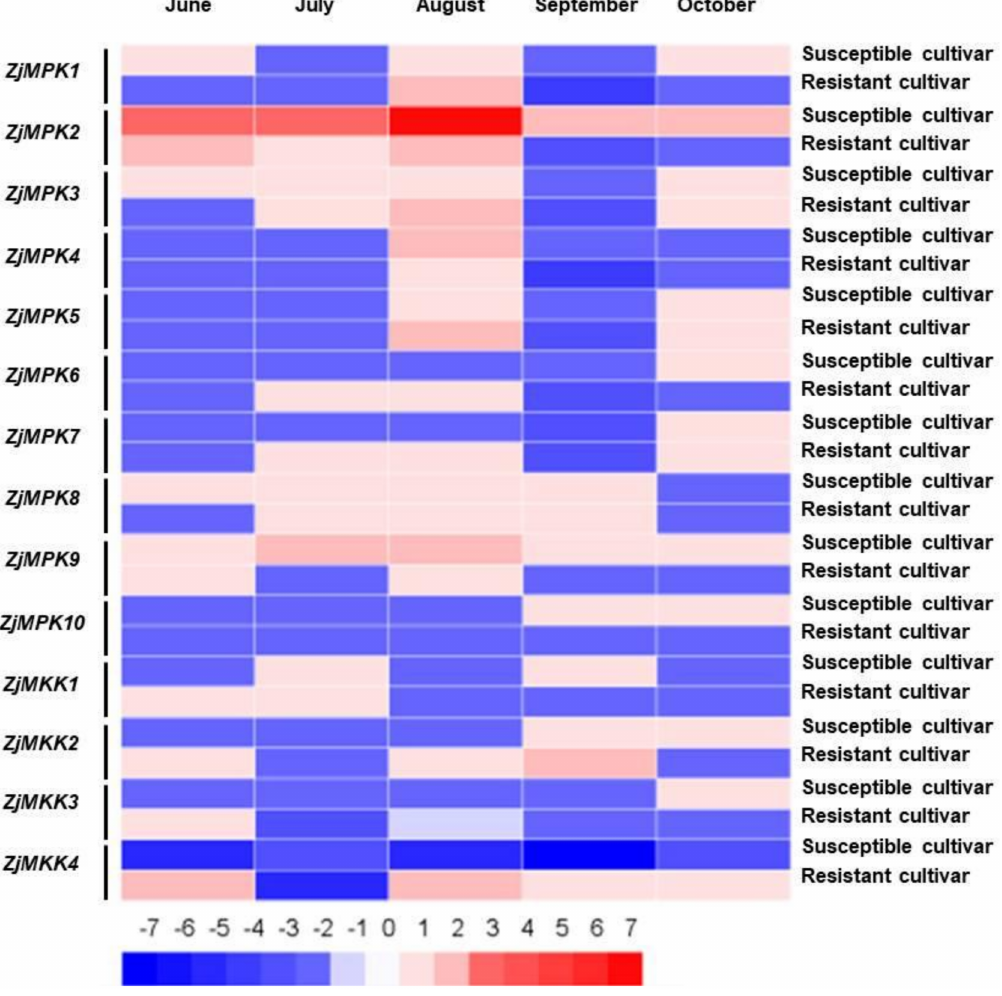
Figure 4. The expression profiles of ZjMPK and ZjMKK genes in JWB-resistant / susceptible cultivars after phytoplasma infection. The heatmap was generated by Heml 1.0 using expression fold-change. Up-regulated genes were colored in red, down-regulated genes were colored in blue (color code in the